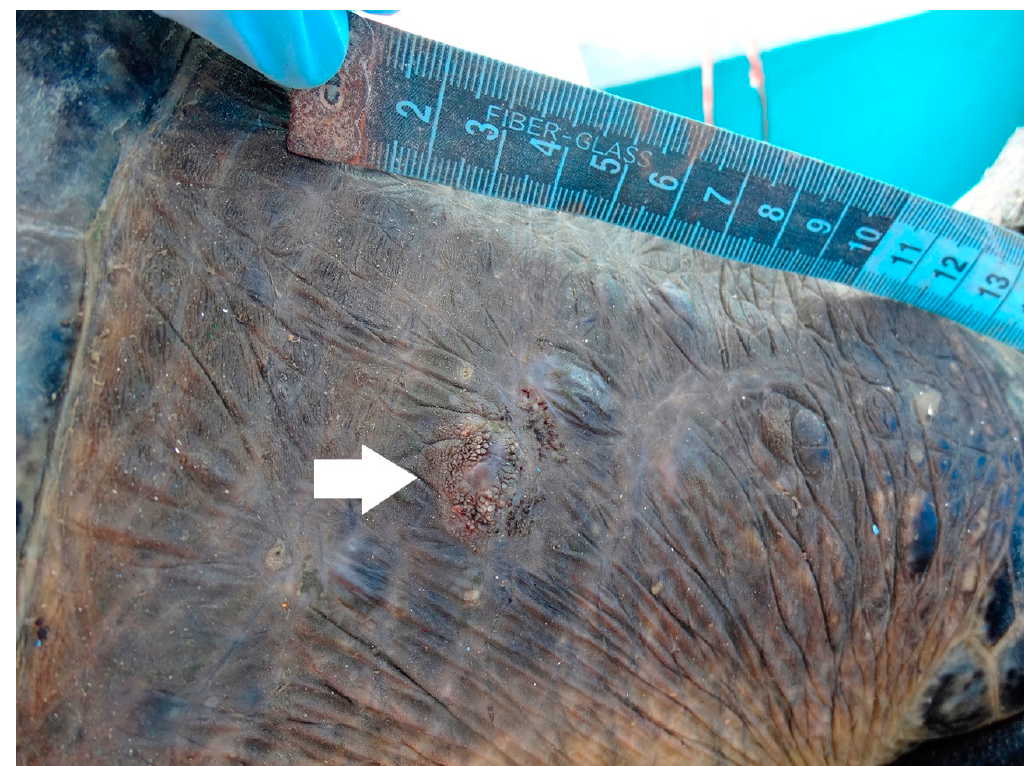
Figure 1. Nodular sessile fibropapilloma of 1.5 cm 3 , with a rough surface, firm consistency, and gray, green, and brown color in the right mediolateral part of the neck of a black turtle ( Chelonia mydas ) in Ojo de Liebre lagoon.